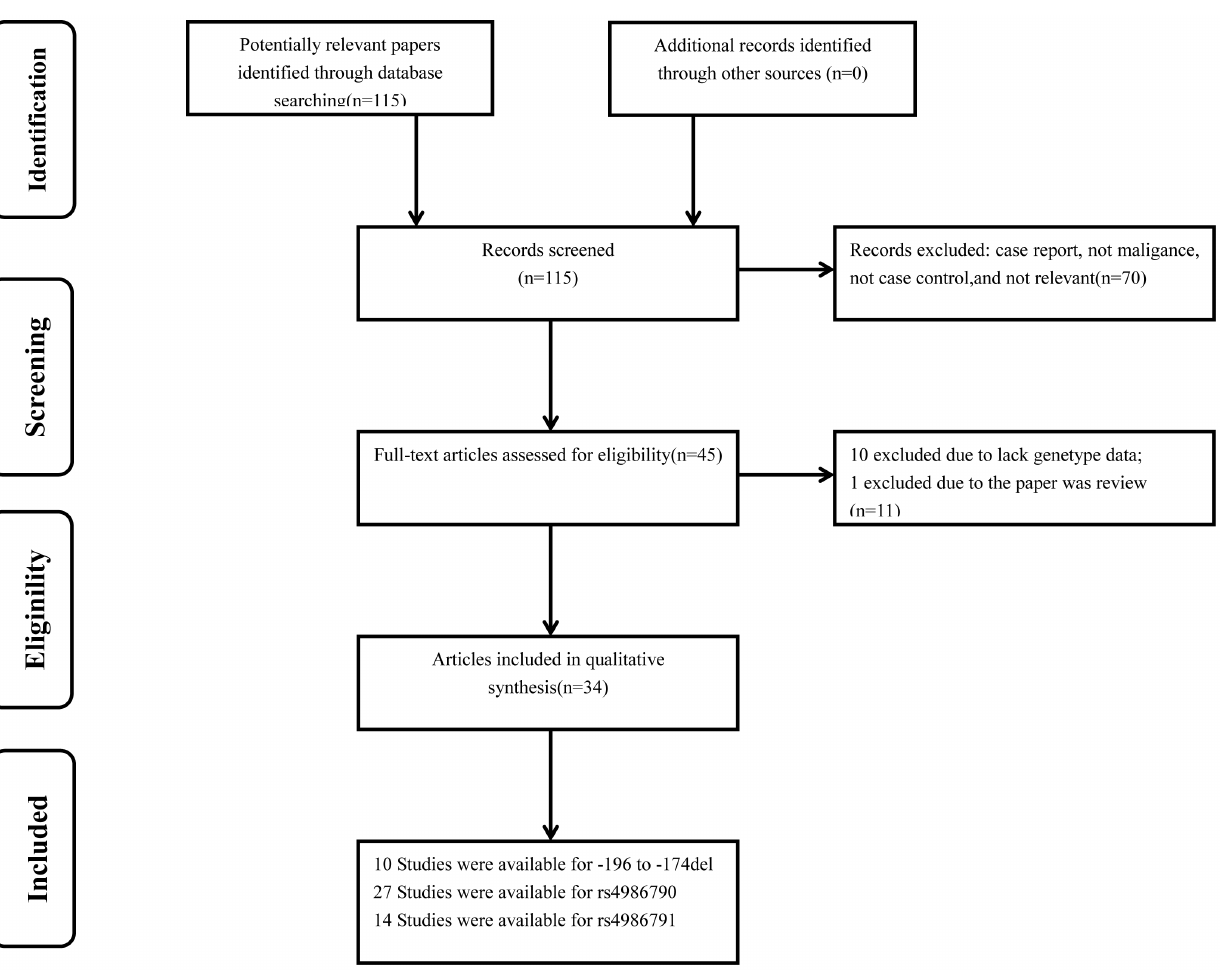
Figure 1. Study selection process.